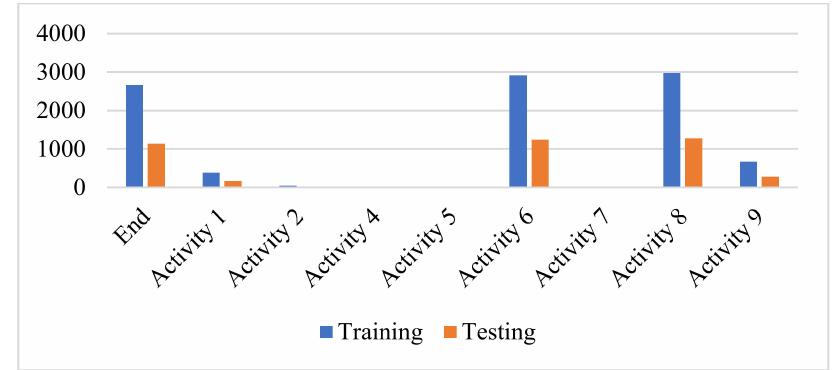
Figure 4. Distribution of training and testing classes in the helpdesk event log.